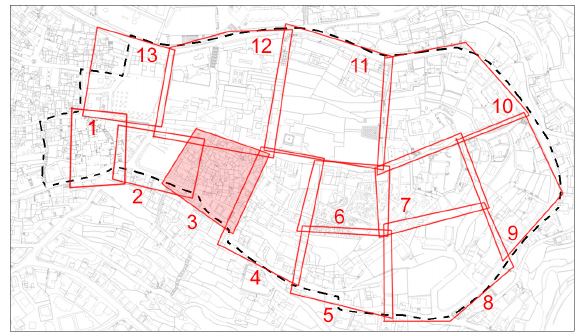
Figure 4: Subdivision plan of the first mission area.